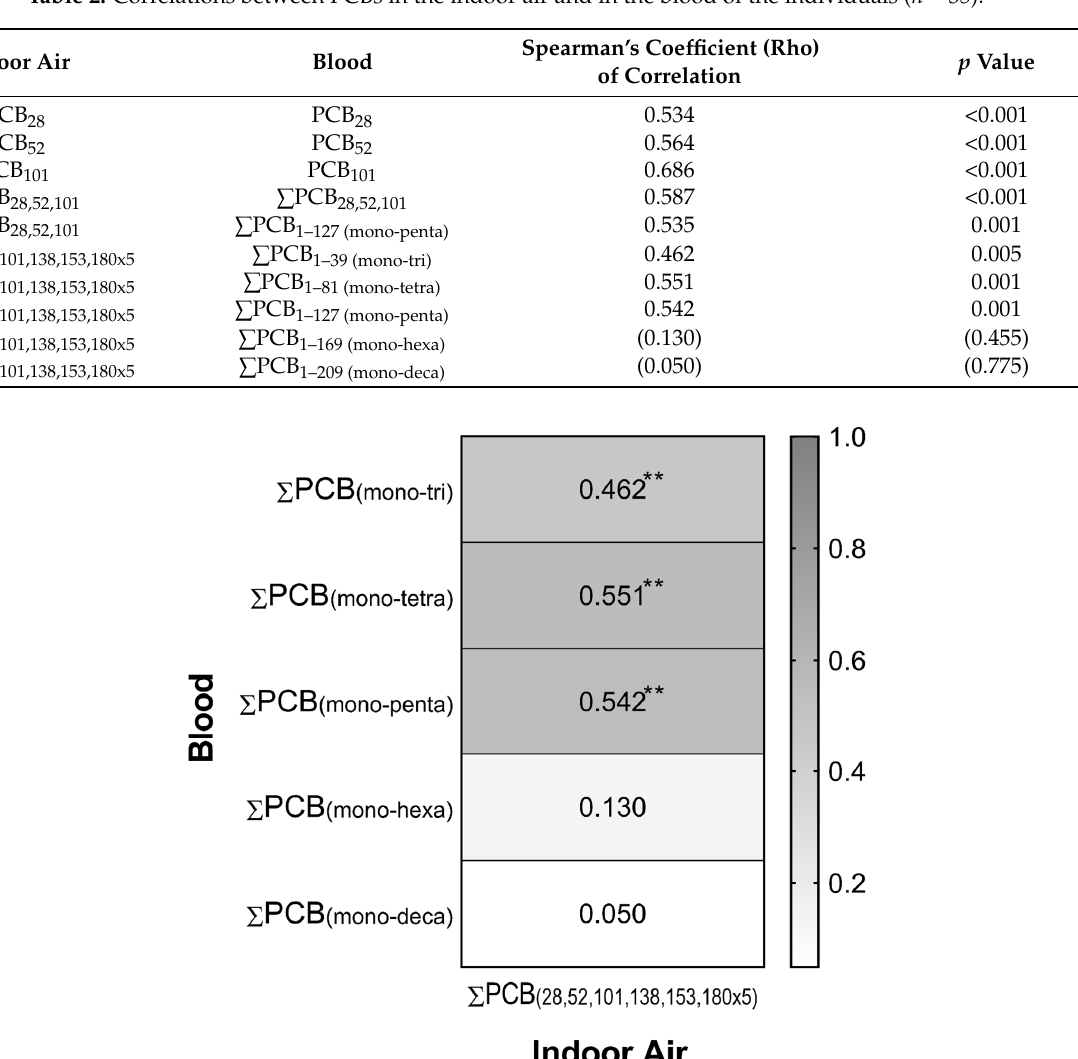
Table 2. Correlations between PCBs in the indoor air and in the blood of the individuals ( n = 35).